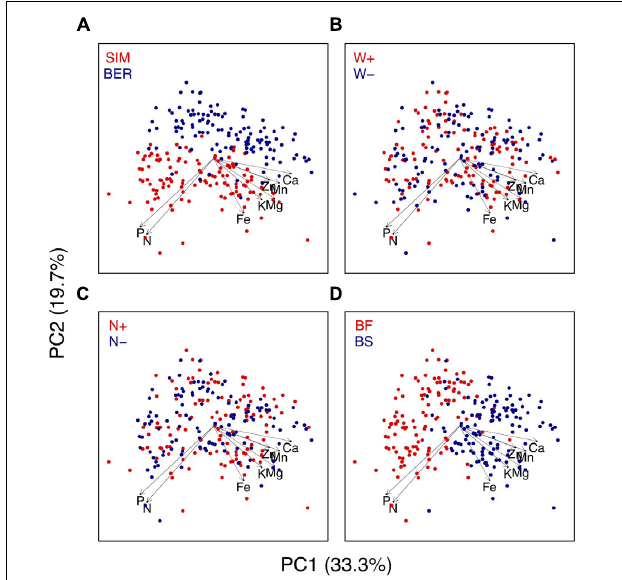
FIGURE 6 | Results of the principal component analysis (PCA). The seven foliar chemical variables (elemental concentrations) are projected along with foliage sample ( n = 240) scores as a function of (A) site, (B) soil warming treatment, (C) canopy N addition treatment, and (D) species.